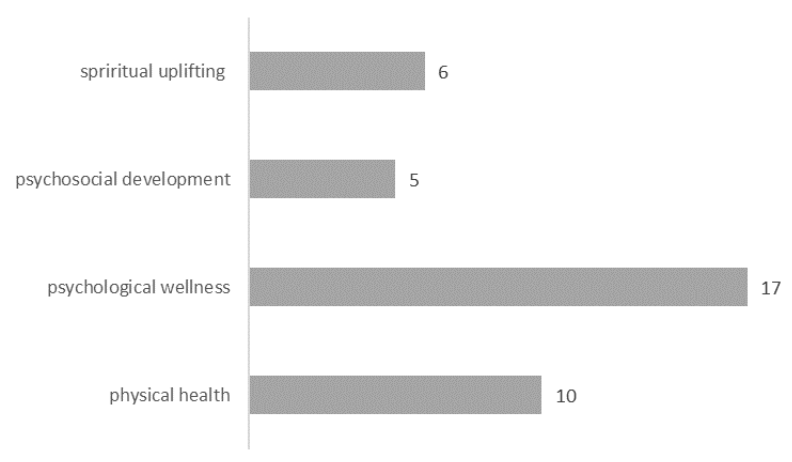
Figure 5. Restorative outcomes from experiences of nature.